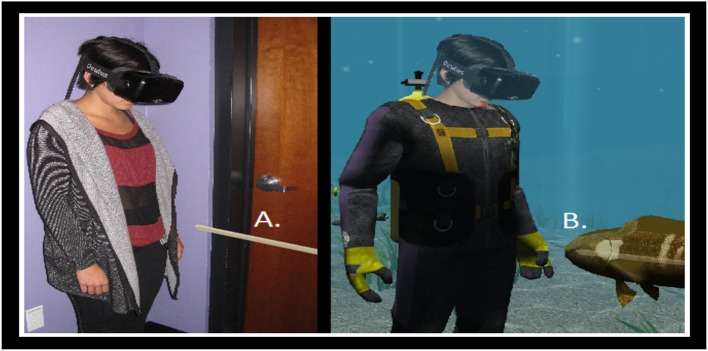
(A) The researcher uses a wooden dowel to tap the participant gently in the abdomen. This haptic feedback corresponds with a simultaneous bumping action that occurs in the virtual environment. (B) A fish approaches the participant's virtual body and bumps it repeatedly. The fish's bumping action coincides with the researcher's gentle tapping action in the real world.